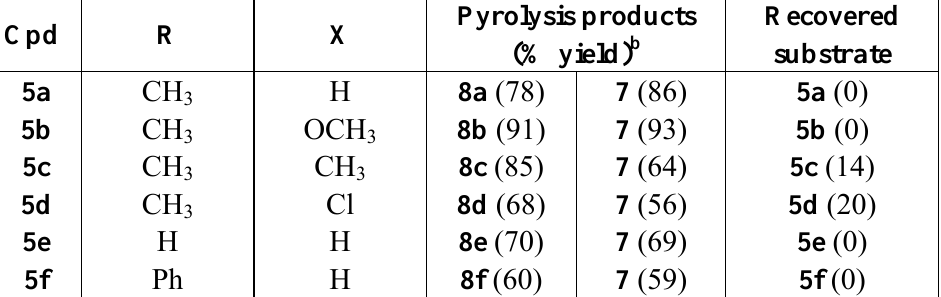
Table 2. Pyrolysis products of 5a-f at 600 °C, 10 -2 Torr and % yield a from